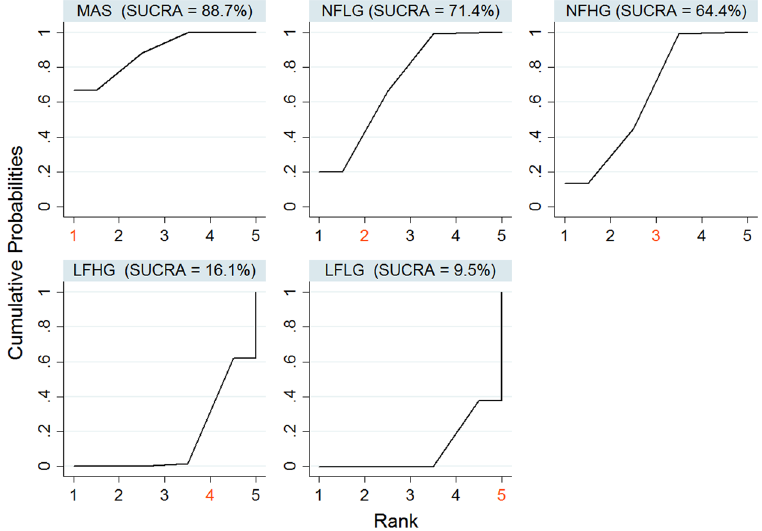
Figure 3. Cumulative probability curves for prognosis for each group with SUCRA values.